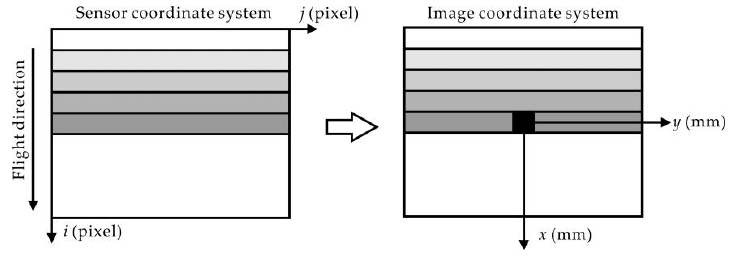
Figure 2. Sensor/screen and image coordinate system.